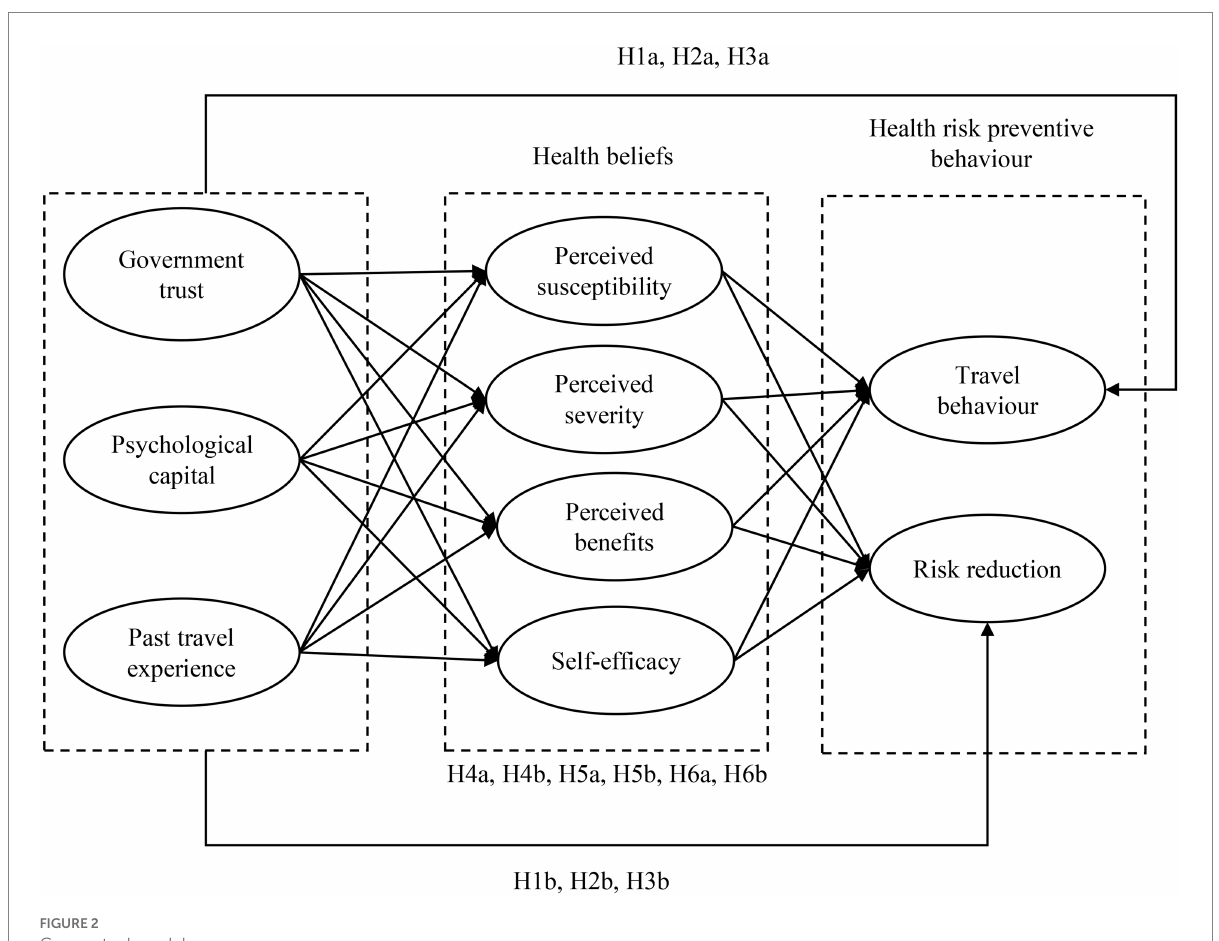
FIGURE 2 Conceptual